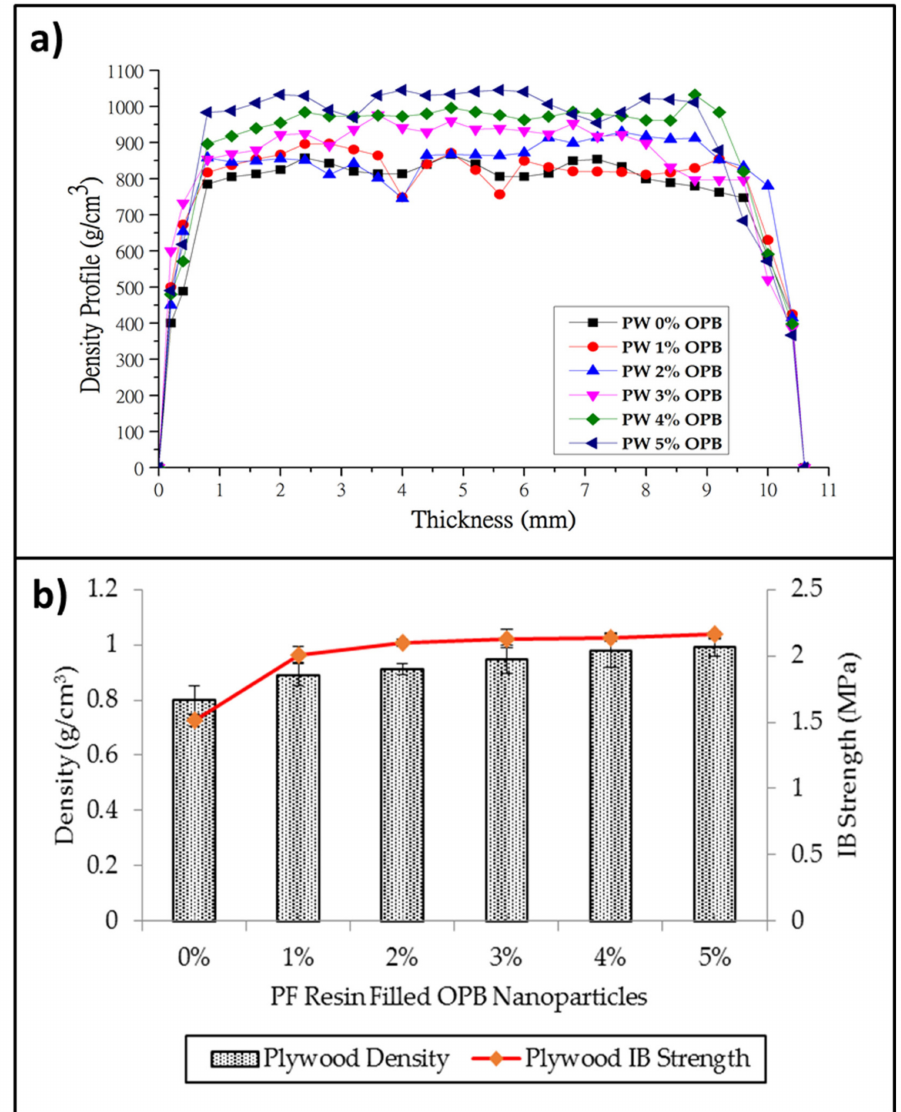
Figure 8. ( a ) Density profile of plywood with PF resin-filled OPB nanoparticles and ( b ) relationship between density and IB strength of plywood